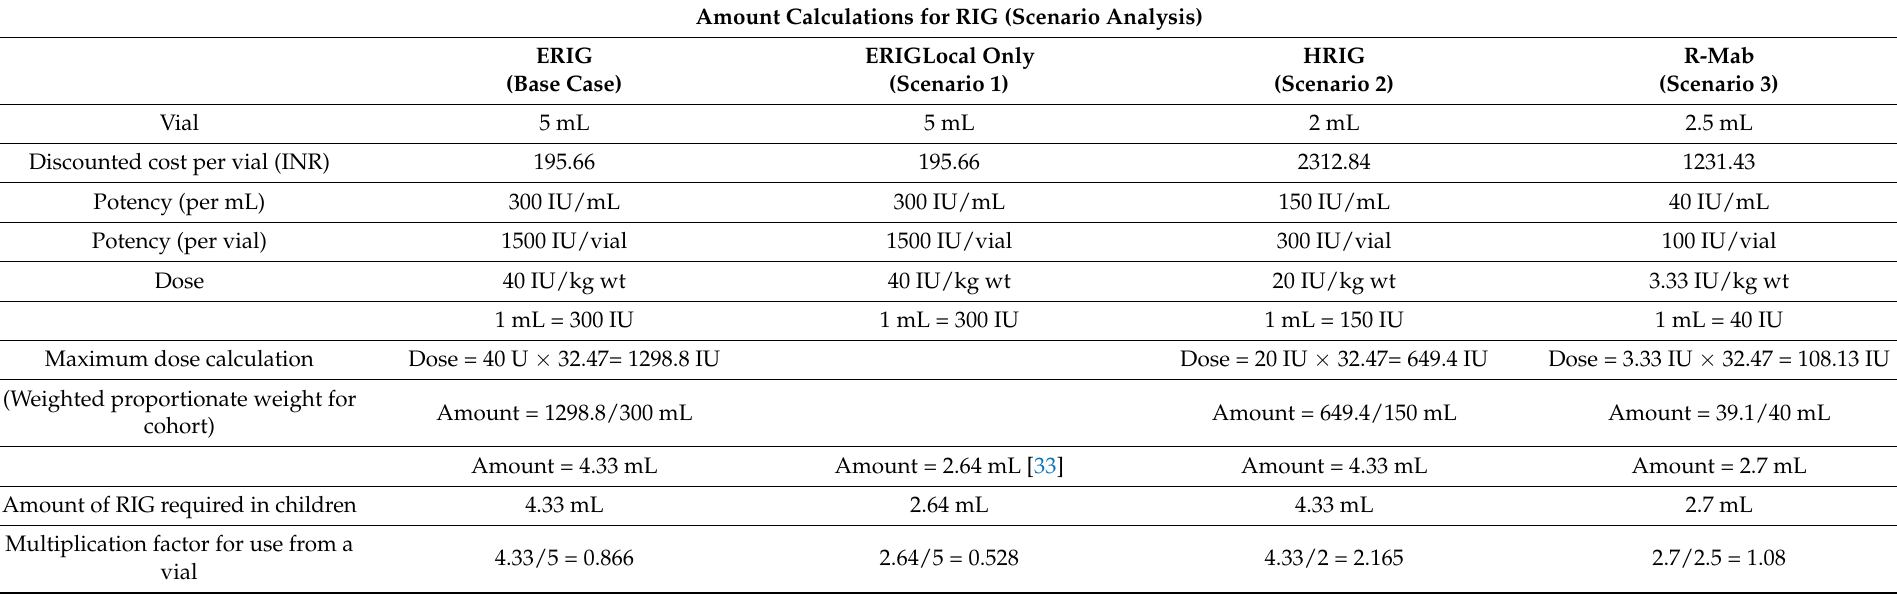
Table A6. Calculations for ERIG, HRIG & R-Mab for Scenario